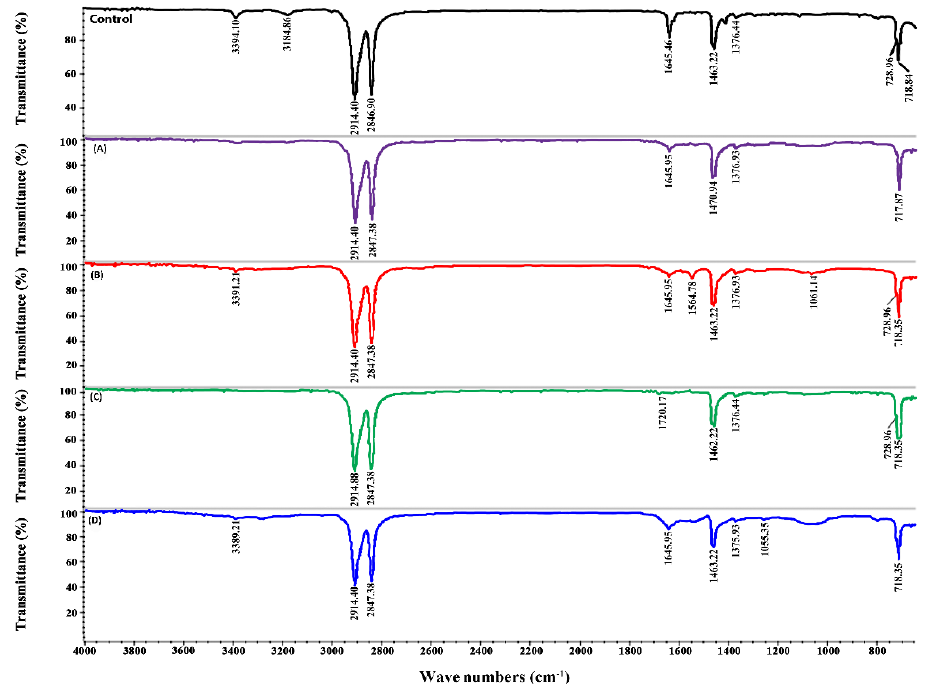
Figure 4. FTIR of epiphyton (EPP) showing new and vanished peaks of PE under Pb 2+ (M1) and Cd 2+ (M2) concentration of 50 mg/L (C2). ( A ) EPP + 13 C + M1C2 + PE, ( B ) EPP + 13 C + PE, ( C ) EPP + 13 C + M2C2 + PE, and ( D ) EPP + NAM + PE. Int. J. Mol. Sci. 2020 , 21 , x FOR PEER REVIEW